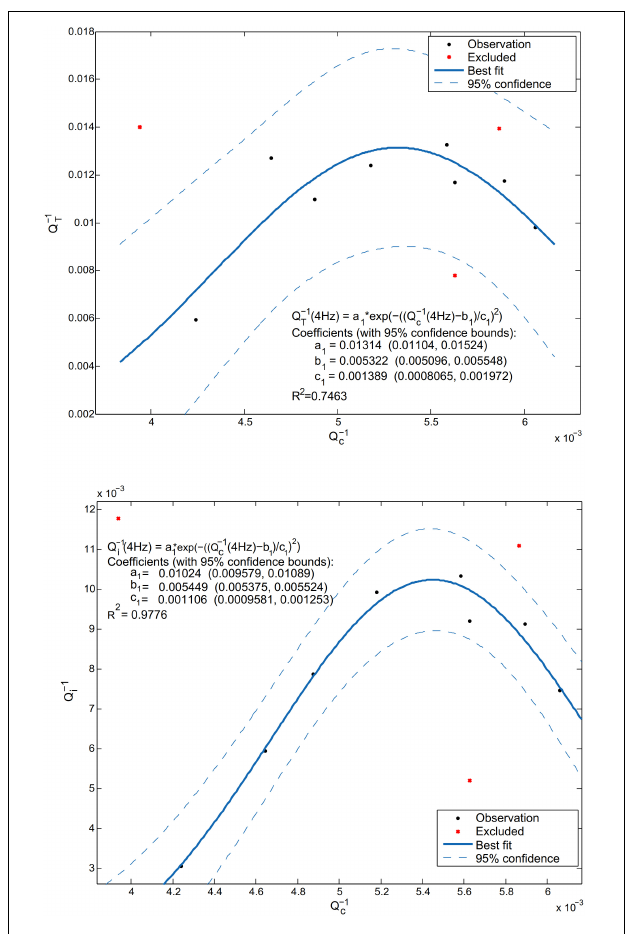
FIGURE 3 | Correlations between Q − 1 c and Q − 1 T (upper panel) at 4 Hz using results presented by Vargas et al. (2004). After analyzing the goodness-of-fit statistics, the best correlation was found using a Gaussian model. For guaranteeing the best fit, we exclude three outliers (located at the North of Colombia) of the eleven stations reported in that study. Similar correlation was performed between Q − 1 c and Q − 1 in (lower